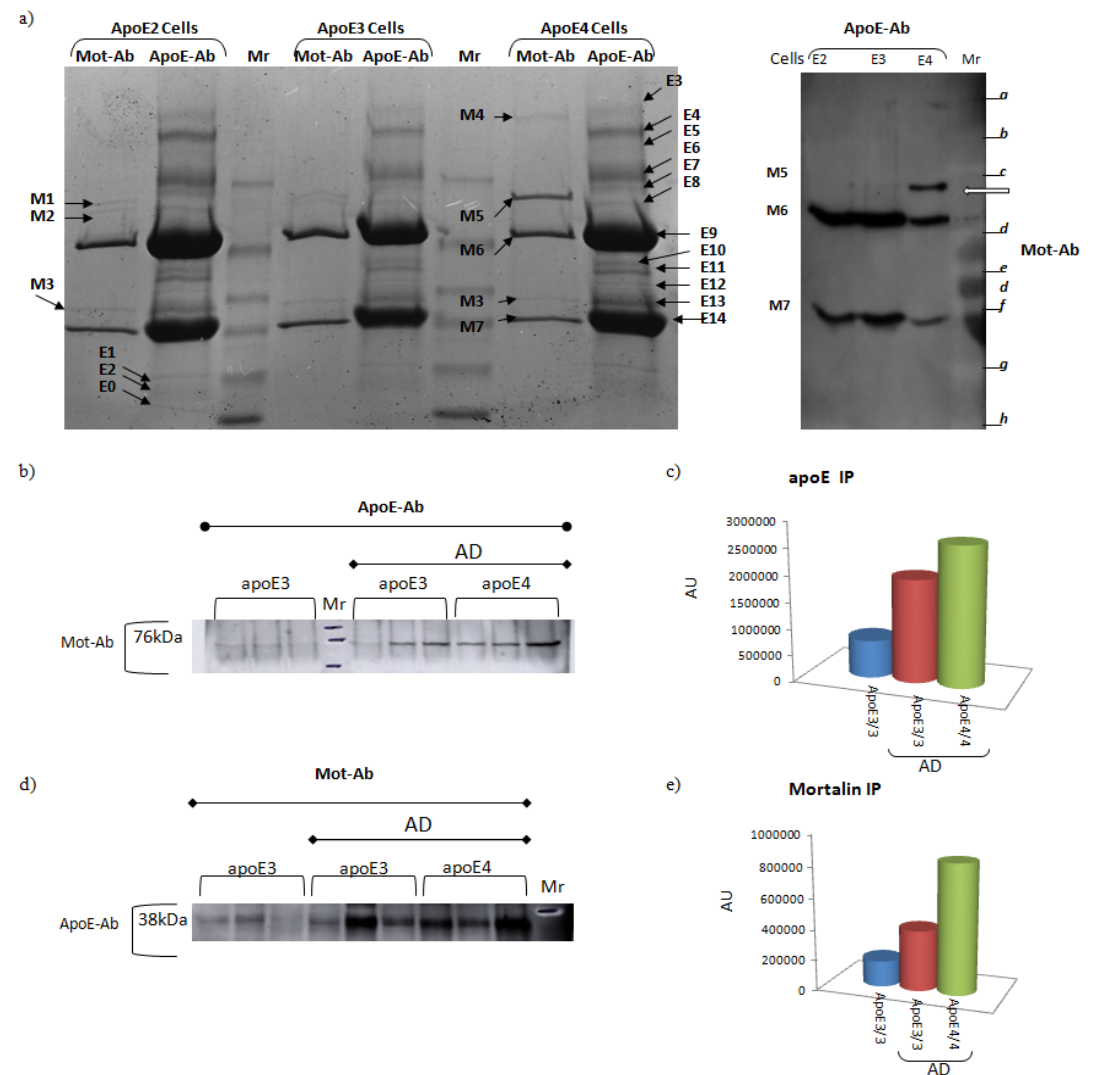
Figure 4 . Potential interaction between mortalin and ApoE in Alzheimer’s disease. ( a ) Astrocytes from hApoE ε 2/2-TR, hApoE ε 3/3-TR, and hApoE ε 4/4-TR mice were solubilized and immunoprecipitated with mortalin (Mot-Ab) or ApoE (ApoE-Ab) antibodies (Left panel). The ApoE-Ab immunoprecipitants were challenged with the Mot-Ab and only the hApoE ε 4/4-TR astrocytes displayed interaction between ApoE and mortalin ((a) Right panel, indicated with a white arrow on the right panel). ( b ) Human brain tissues from hippocampus, were solubilized as described [20], followed by immunoprecipitation with an ApoE antibody. The immunoprecipitated proteins were separated in a 10% SDS-PAGE gel, transferred to a PVDF membrane, and immunoblotted with a Mot-Ab. Quantitation of the mortalin-apoE bands indicates that the binding is genotype- and disease-dependent ( c ). The complementary experiment, in which mortalin is immunoprecipitated with the Mot-Ab, and the IP is immunoblotted against ApoE-Ab ( d,e ) shows almost identical results. Proteins were identified by MALDI-TOF/TOF mass spectrometry (white arrow). “M” indicates proteins that were immunoprecipitated with the mortalin antibody and identified by mass spectrometry; correspondingly, “E” represents proteins that were immunoprecipitated with the apoE